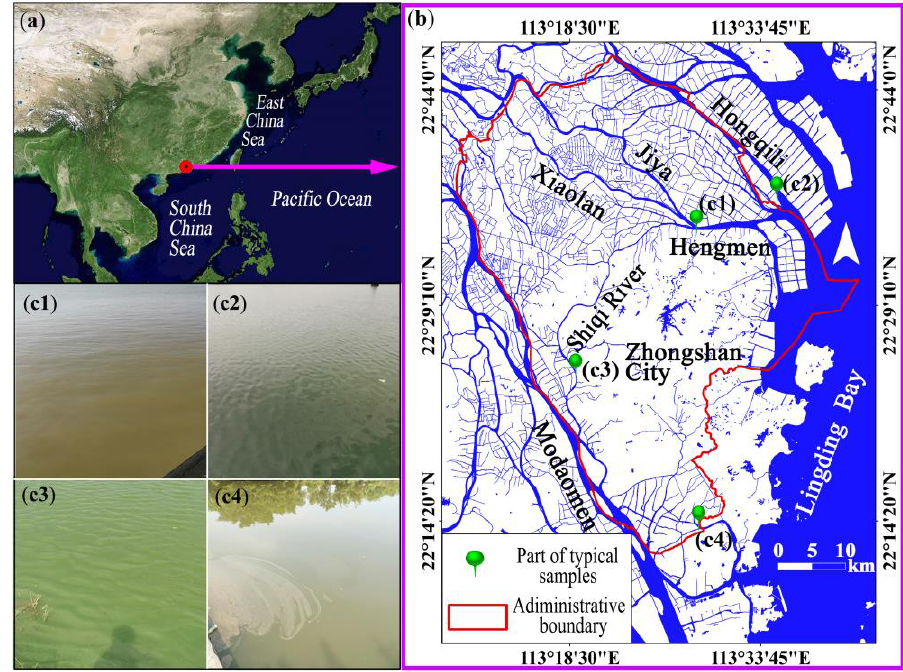
Figure 1. ( a ) Location of the study area; ( b ) drainage distribution in the study area; ( c ) field photos of some typical sampling points (( c1 – c4 ), corresponding to the sampling point numbers in ( b )).